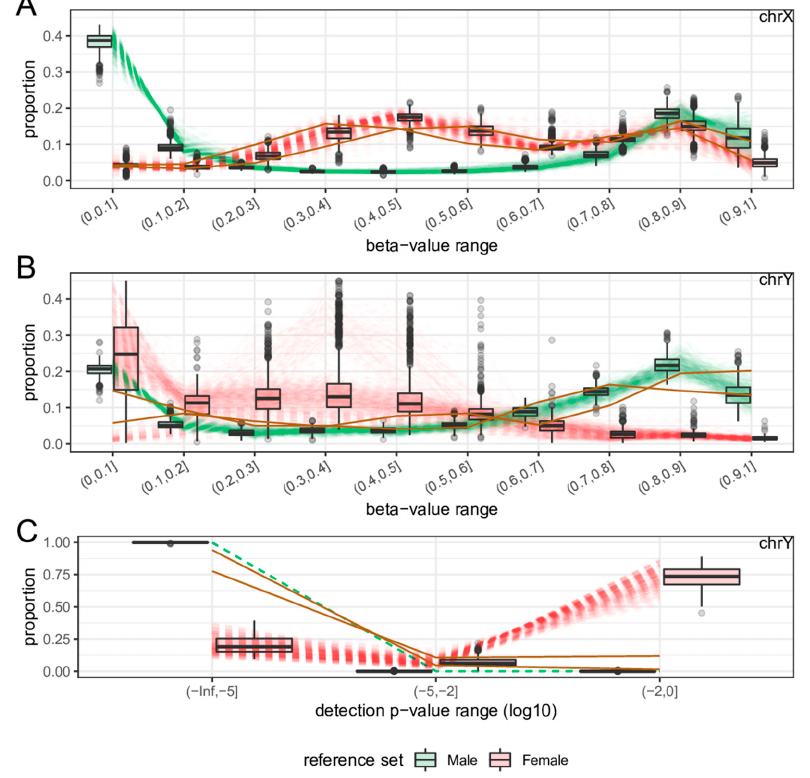
Figure 7. Beta-value/detection p -value distributions of two N-samples from dataset GSE51032. The patterns of N-predicted samples are shown in solid gold lines, and those of reference samples are shown in dashed lines and as boxplots. N-predicted samples show female-like chrX profiles ( A ) and male-like chrY profiles ( B , C ).